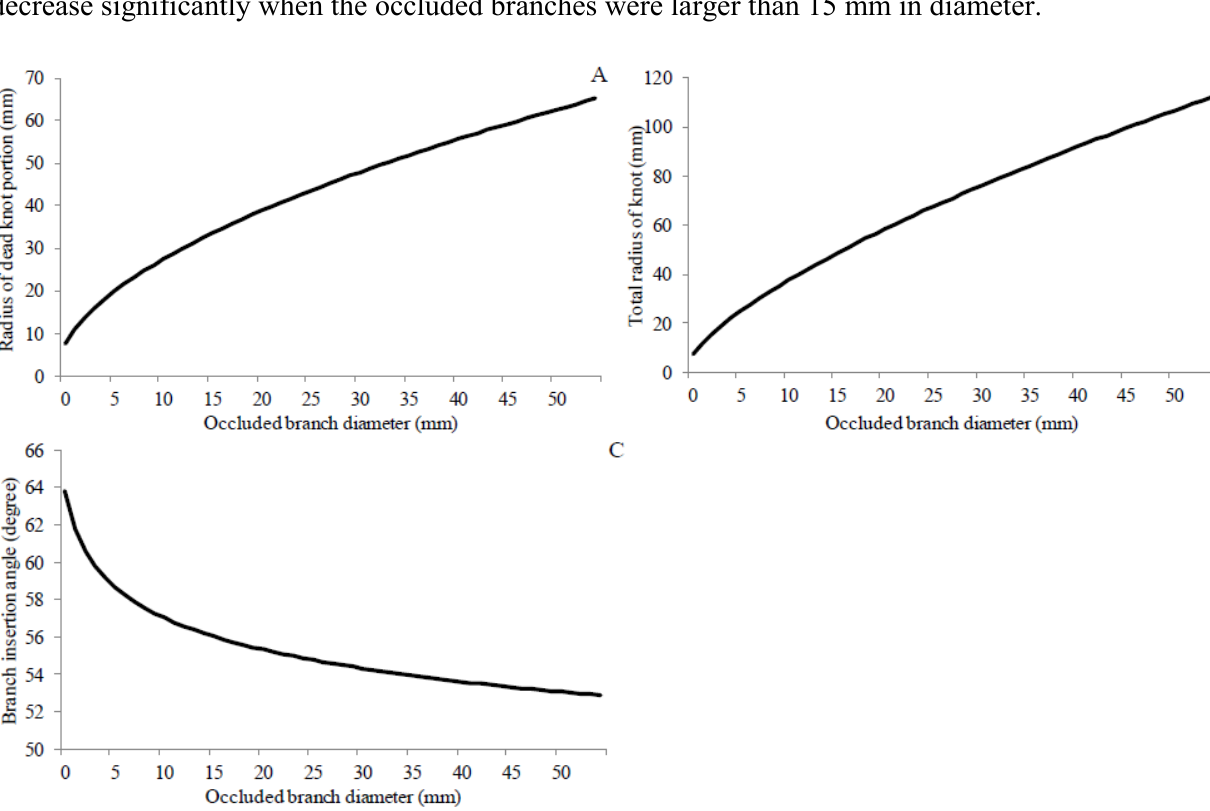
Figure 7. Predicted radius of dead portion of knot (( A ), Equation (2)), total radius of knot (( B ), Equation (3)) and insertion angle of occluded branch (( C ), Equation (4)) plotted against occluded branch